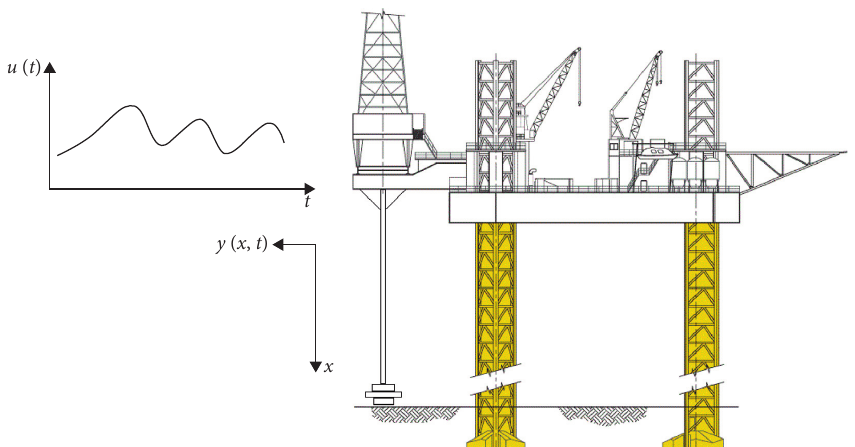
Figure 2: The sketch map of the jack-up drilling